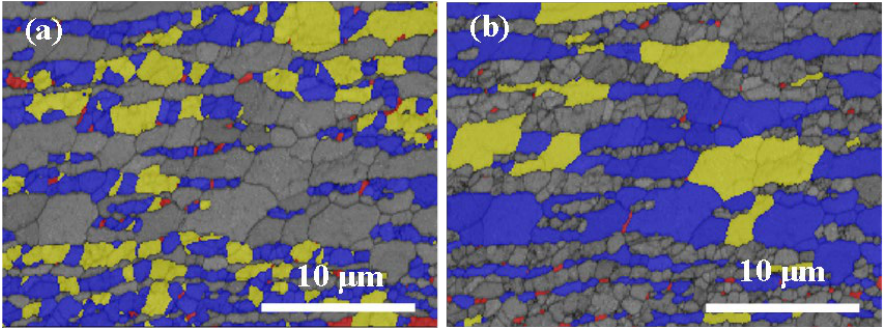
Figure 8. Recrystallized fraction (RF) maps of the center: ( a ) austenite and ( b ) ferrite (fully recrys- tallized grains are shown in blue, the deformed grains and the sub-structured grains are in red and yellow, respectively).